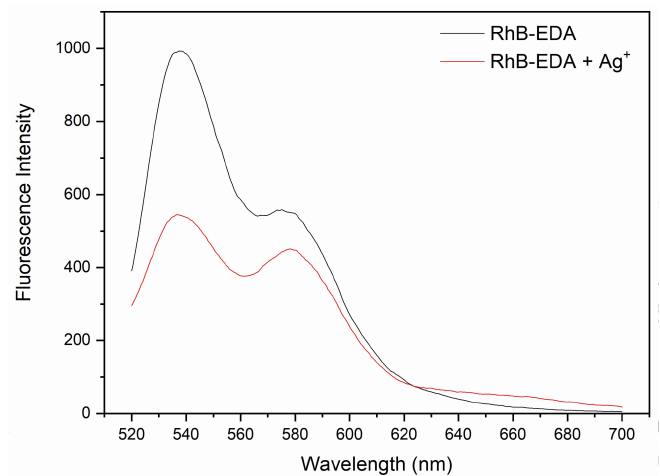
Figure 7. Fluorescence spectra of RhB-EDA alone (10 − 4 M) and RhB-EDA (10 − 4 M) after addition of 10 − 4 M Ag + ions ( λ ex / λ em = 500/538 nm).